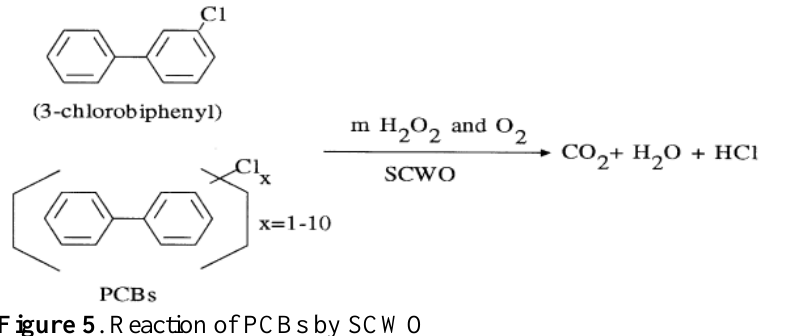
Figure 5 . Reaction of PCBs by